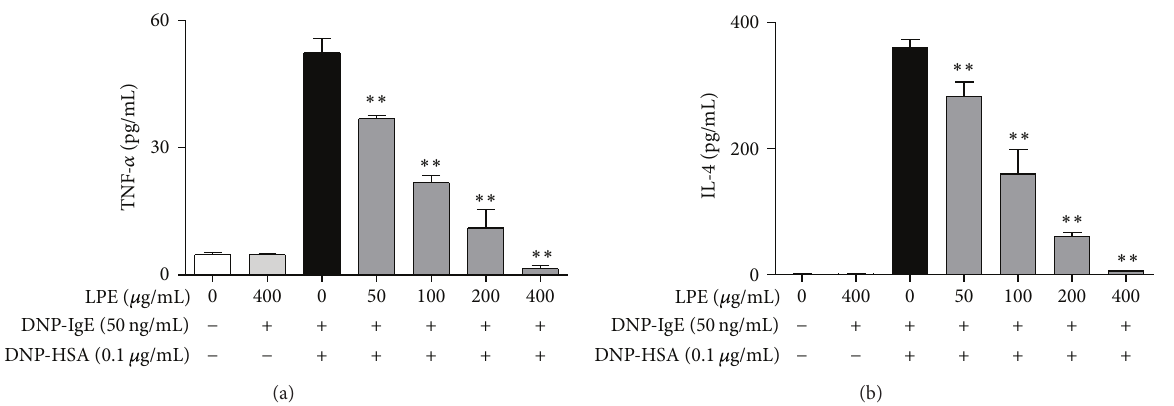
Figure 2: Inhibitory effect of LPE on proinflammatory cytokines. IgE-sensitized RBL-2H3 cells were preincubated with LPE for 1h prior to antigen challenge. TNF- 𝛼 and IL-4 levels were determined as described in Section 2. Data are mean ± SD values of triple determinations. ∗∗ 𝑃 < 0.01 versus DNP-HSA-treated group. (a) TNF- 𝛼 ; (b) IL-4.